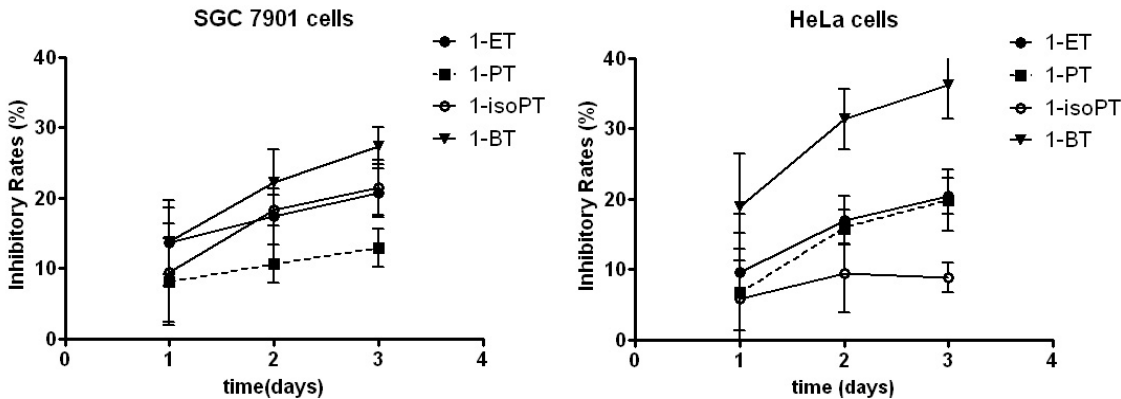
determinations.* p < 0.05, compared with control. ** p < 0.01, compared with